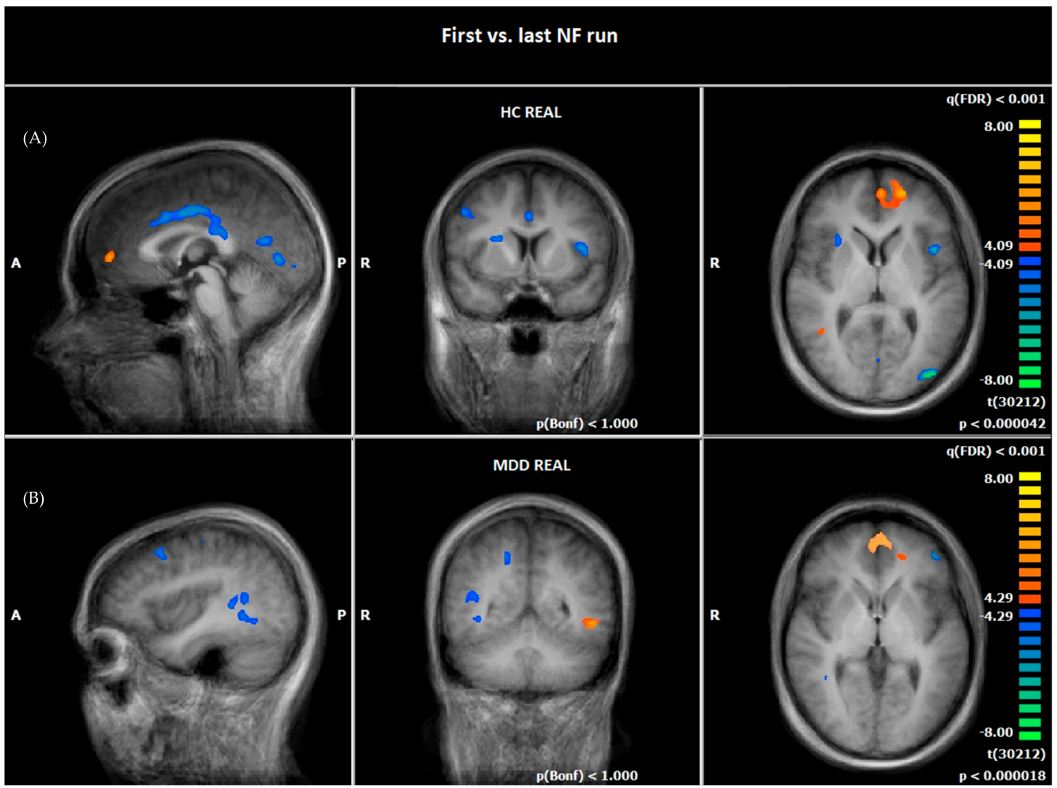
Figure 3. Hemodynamic responses of the first vs. the last NF run (negative emotional pictures > neu- tral pictures; q (FDR) < 0.001, T-score: − 8 to 8, fixed-effects-analysis). ( A ) The HC REAL group demonstrated increased hemodynamic responses, e.g., in the ventromedial prefrontal cortex (orange) and a reduced BOLD-signal (blue) in emotion processing areas, e.g., insula, anterior and posterior cingulate cortex, parahippocampal gyrus, and basal ganglia, after NF training (x = 0; y = 0; z = 7). ( B ) The MDD REAL group demonstrated increased brain responses (orange) in the ventromedial prefrontal cortex and inferior frontal cortex and a reduced BOLD-signal (blue) in emotion processing areas, e.g., parahippocampal gyrus and dlPFC, after NF training (x = 38; y = -50; z = 3). A = anterior, P = posterior, R =